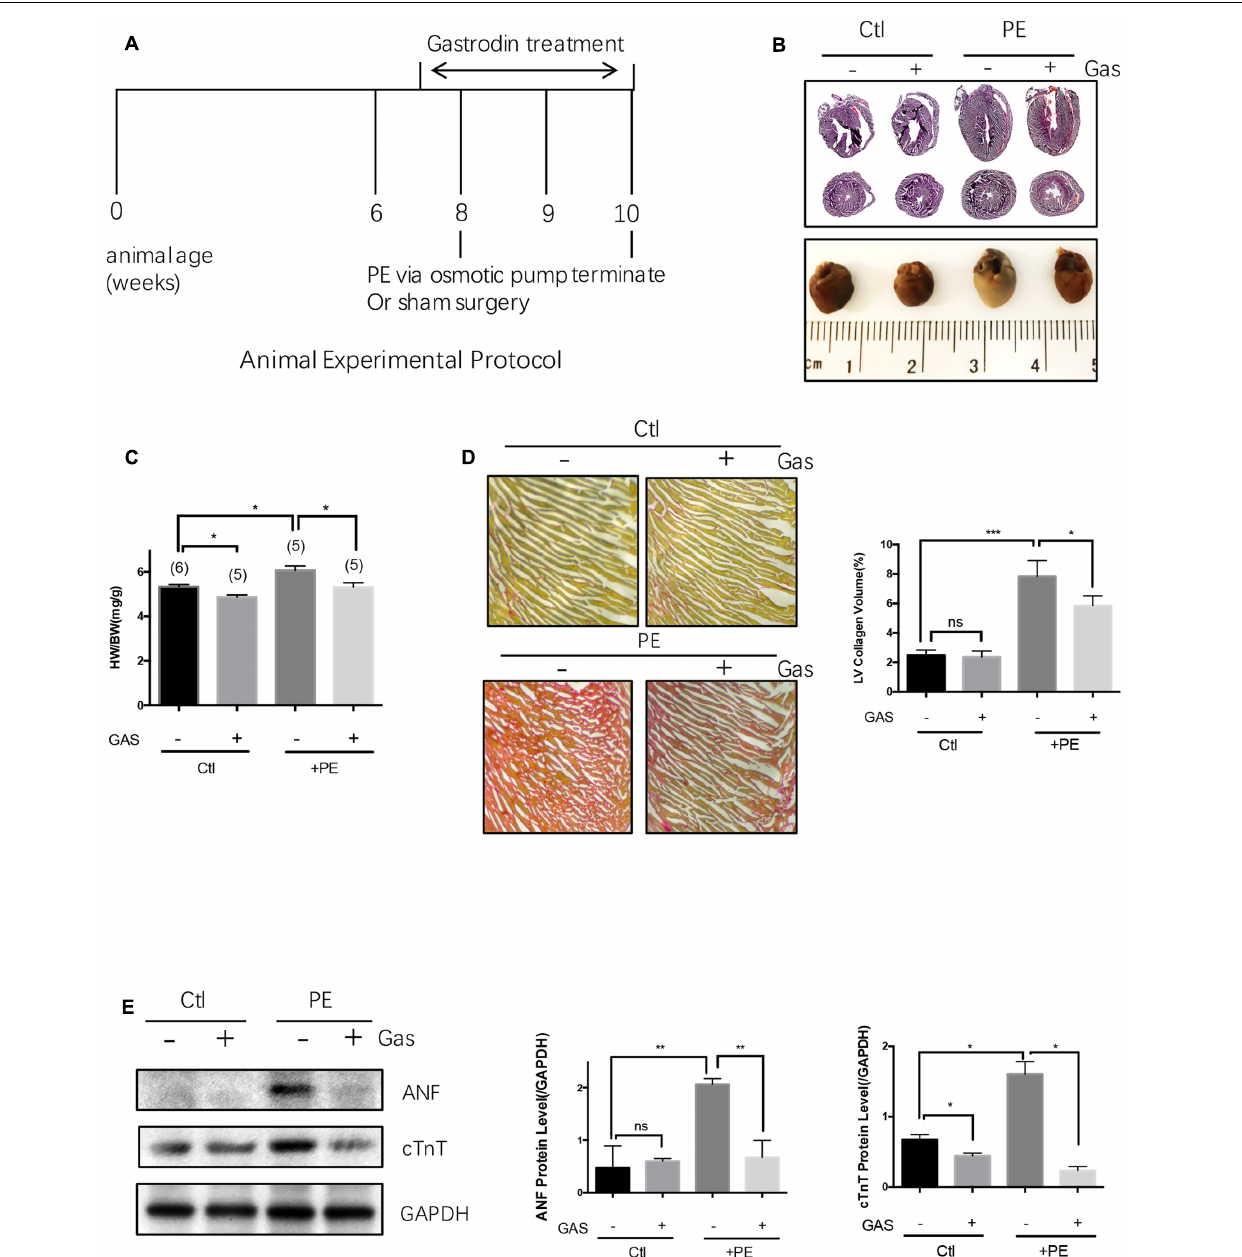
FIGURE 1 | Gastrodin inhibited the phenylephrine (PE)-induced cardiac hypertrophy and fibrosis in vivo. Mouse cardiac hypertrophic model. (A) Shows the schematic experimental protocol. The mice were infused with PE at a dose of 70 mg/kg/day for 2 weeks. The gastrodin (GAS, 50 mg/kg/day) injection started 1 week before PE. The control group (Ctl) did not undergo PE treatment. Hypertrophy was assessed by measuring heart size ( B , representative from 6 pairs of mice) and the ratio of heart weight (HW)/total body weight (BW) ( C , n = 5–6). (D) Shows the change in collagen content in mouse hearts with representative images and data summary ( n = 5). Sections are stained with picrosirius red and collagen fibers appear red. (E) Shows the changes in ANF and cTnT protein expression with representative images and data summary ( n = 5). The data are expressed as the mean ± SEM ( n = 5–6 repeats). ∗ p < 0.05; ∗∗ p < 0.01; ∗∗∗ p < 0.001. ns, not